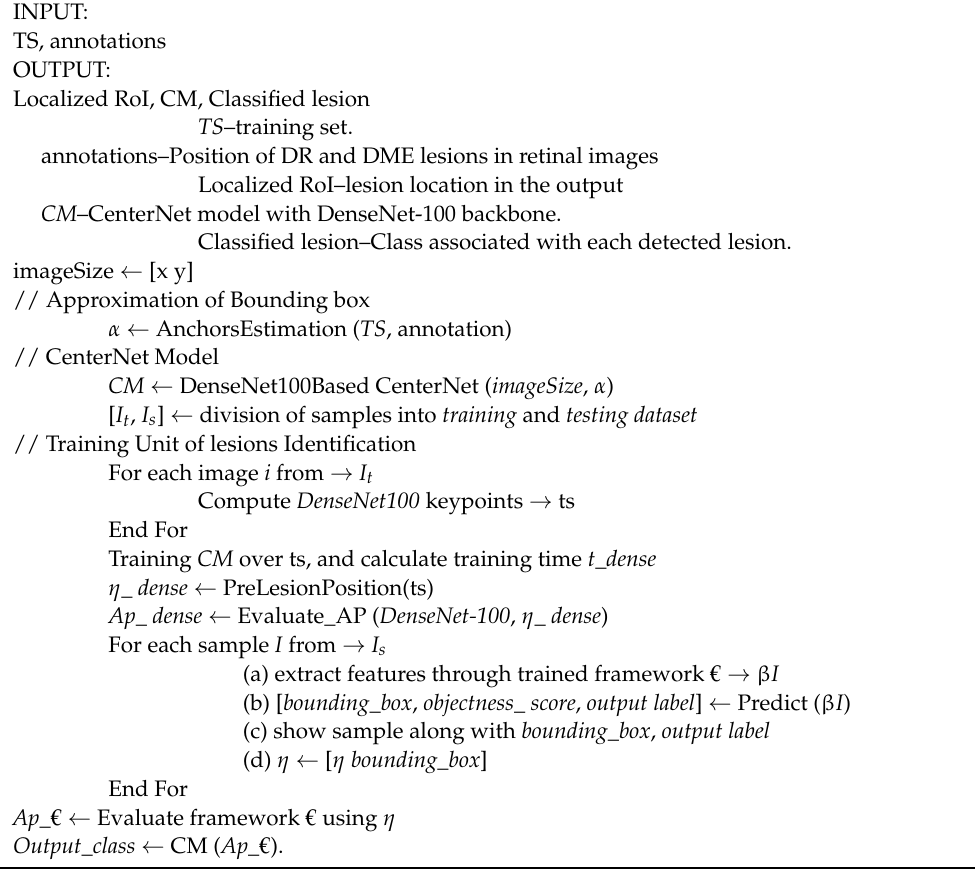
Algorithm 1 Steps to train the Custom CenterNet model